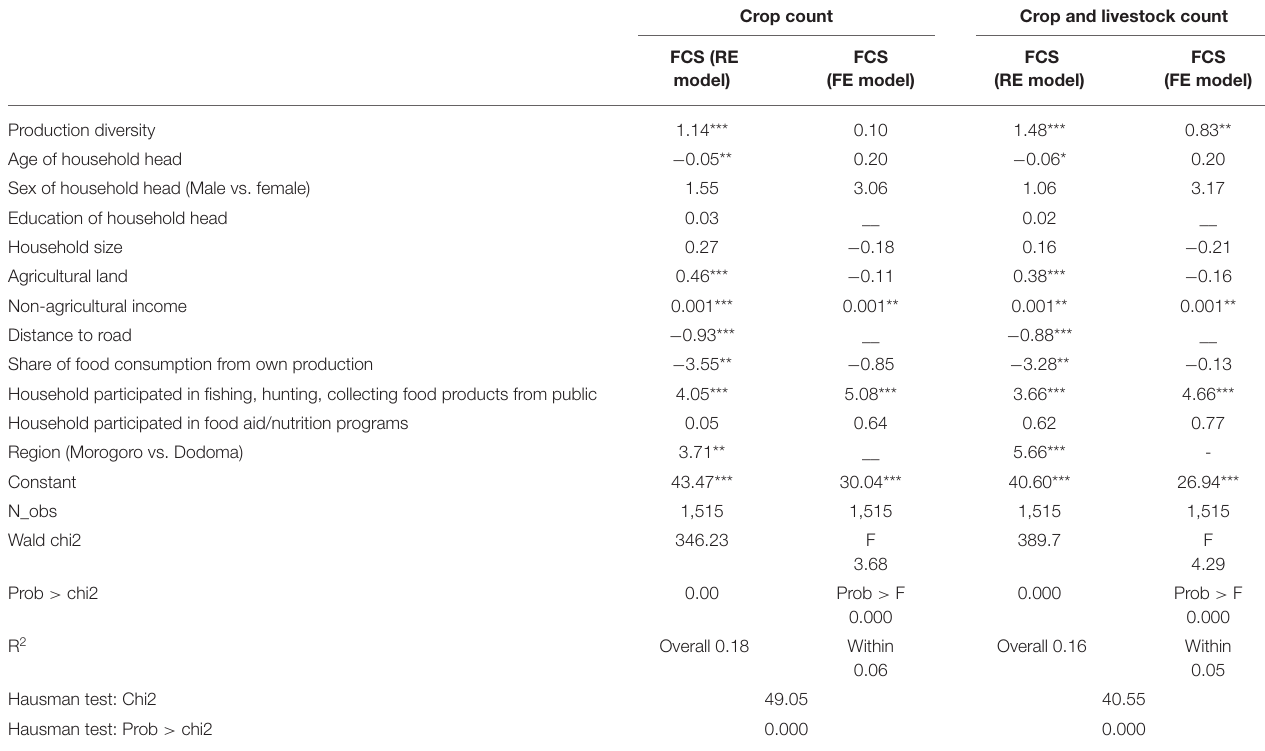
TABLE 5 | Panel regression results on the association between production diversity and dietary